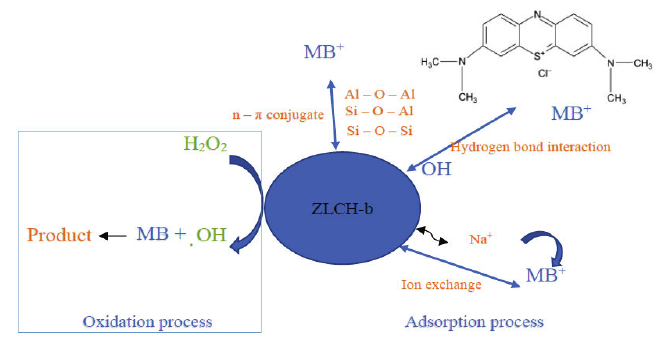
Figure 9: The proposed mechanisms of adsorption and oxidation simultaneously.